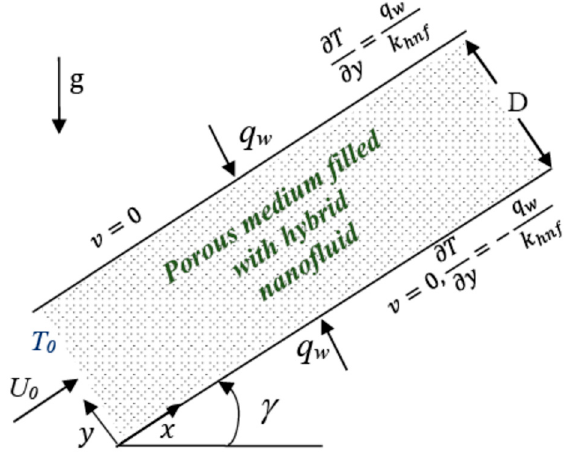
Figure 1. The channel configuration.